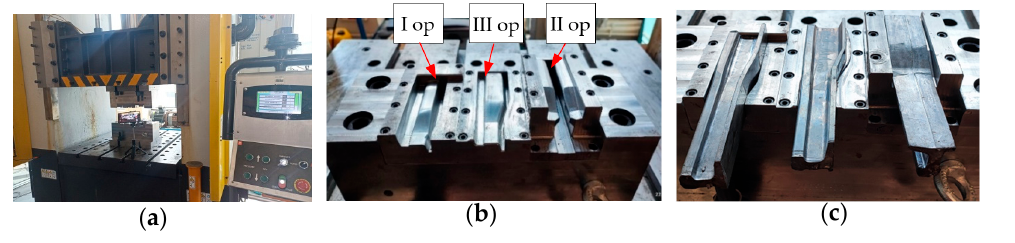
Figure 10. Images of: ( a ) the physical modeling station, ( b ) the lower tools for three operations of reforging a lead rail, ( c ) the formed rails placed in the lower dies.